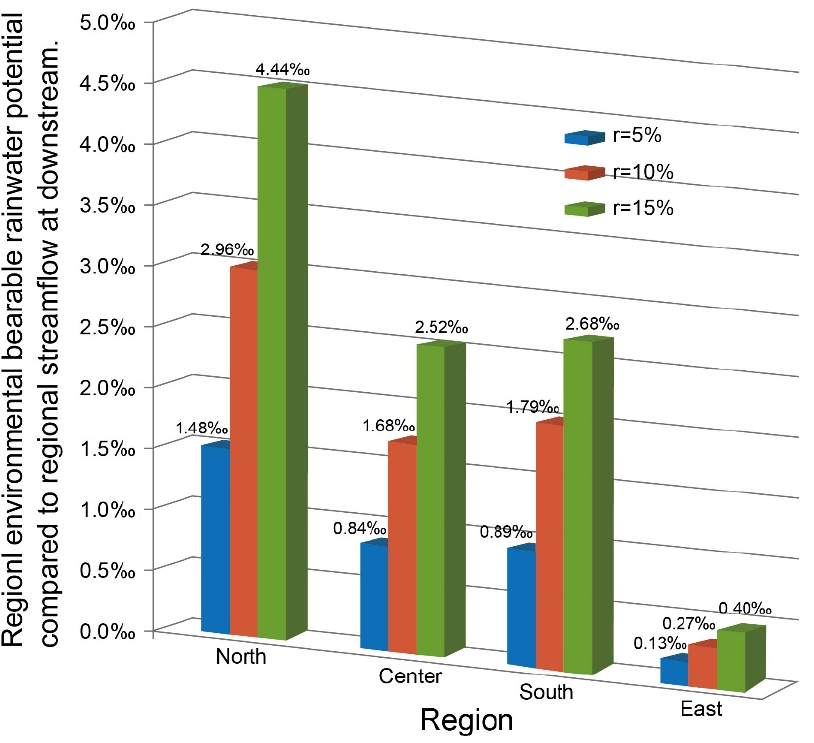
Figure 8. Regional environmental bearable rainwater potential compared to regional streamflow at downstream for selected percentages of total roof area in four